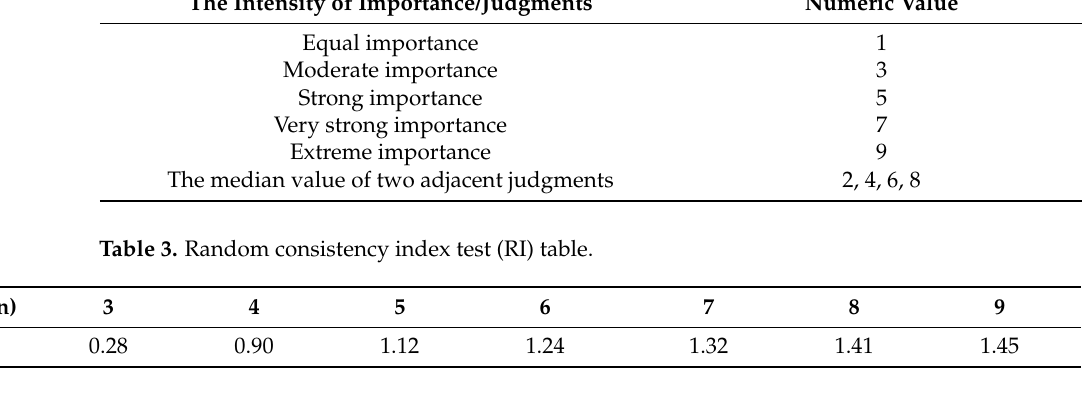
Table 4. Weight of